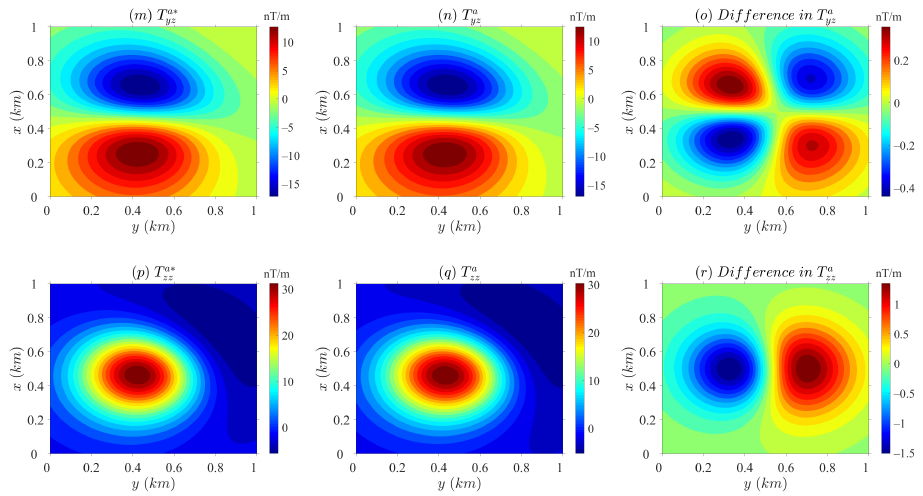
Figure 6. Surface anomalous magnetic gradient fields produced by a magnetic prolate ellip- soid with susceptibility of 10 SI. T a ∗ xx , T a ∗ xy , T a ∗ xz , T a ∗ yy , T a ∗ zz , T a ∗ yz denote the analytical solutions, and T a xx , T a xy , T a xz , T a yy , T a zz , T a yz denote the numerical results calculated using the proposed algorithm. Table 3. Statistical parameters of the misfits for the spherical shell and the prolate ellipsoid. Gradient